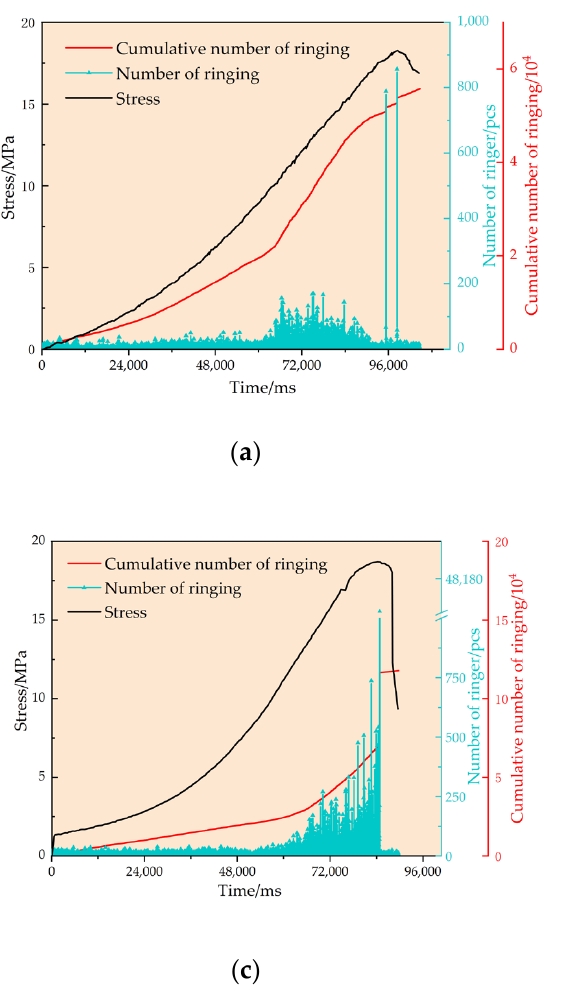
Figure 8. Acoustic emission characteristics of uniaxial compression of fracture-grouted rock specimens with different numbers of wetting–drying cycles. ( a ) 0 cycles. ( b ) 5 cycles. ( c ) 10 cycles. ( d ) 20